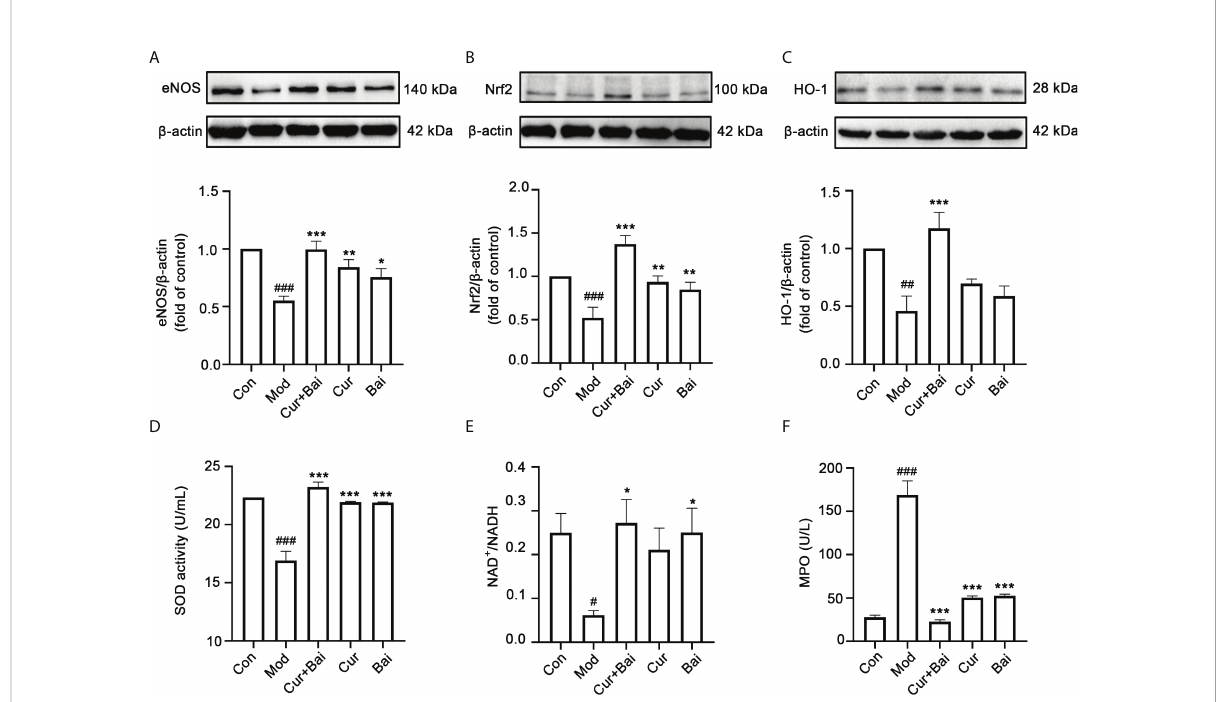
FIGURE 6 The treatment of Cur+Bai upregulated eNOS protein expression, Nrf2-HO-1 mediated antioxidant activity and downregulated MAPKp38-JNK pathway in the entire aorta wall in the diabetic rats. (A) Cur+Bai, Cur and Bai upregulated eNOS protein expression in diabetic rats as analysed by the Western blot analysis. n=3, ### p <0.001 vs. control group, * p <0.05, p <0.01, p <0.001 vs. model group. (B) Cur+Bai, Cur and Bai upregulated Nrf2 protein expression in diabetic rats as analysed by the Western blot analysis. n=3, ### p <0.001 vs. control group, ** p <0.01, *** p <0.01 vs. model group. (C) Cur+Bai upregulated HO-1 protein expression in diabetic rats as analysed by the Western blot analysis. n=3, ## p <0.01 vs. control group, *** p <0.001 vs. model group. (D) Cur+Bai, Cur and Bai upregulated the SOD enzymatic activity (U/mL). n=5 per group, ### p <0.001 vs. control group, *** p <0.001 vs. model group. (E) Cur+Bai and Bai promoted the NAD+/NADPH ratio. n=5 per group, # p <0.05 vs. control group, * p <0.05 vs. model group. (F) Cur+Bai, Cur and Bai downregulated the MPO expression (U/mL) in the diabetic rats. n=5 per group, # p <0.05 vs. control group, * p <0.05 vs. model group. Results were expressed as mean ± SEM for fi ve rats per group. The p values were obtained from one-way ANOVA